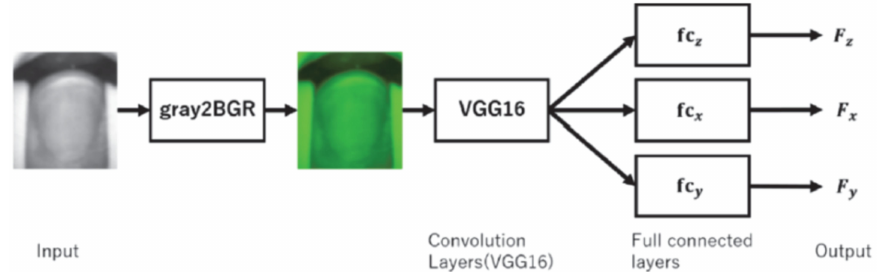
Figure 4. Structure of deep learning model. Input image data are processed by gray2BGR to